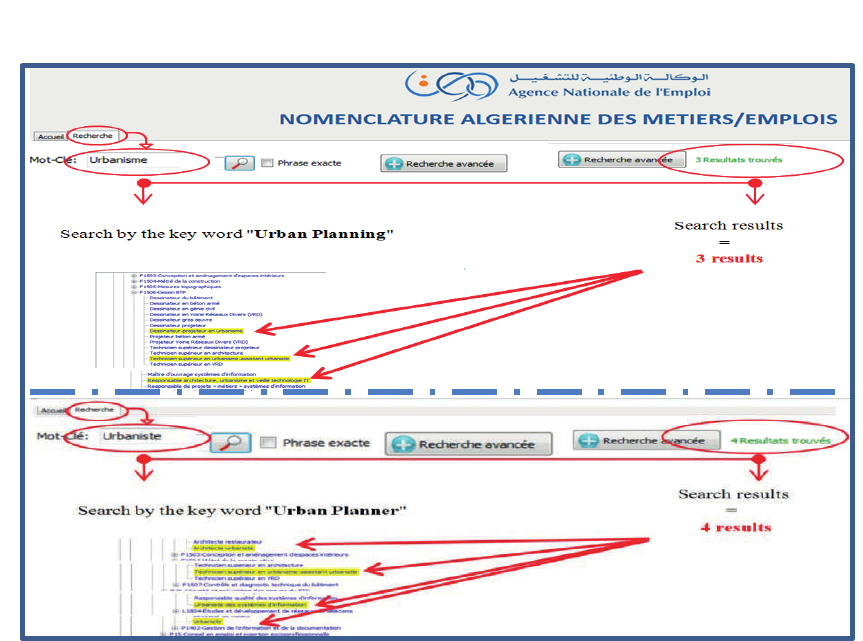
Fig. 3. Search results of the urban planner trade using «Urban Planning and Urban Planner” key